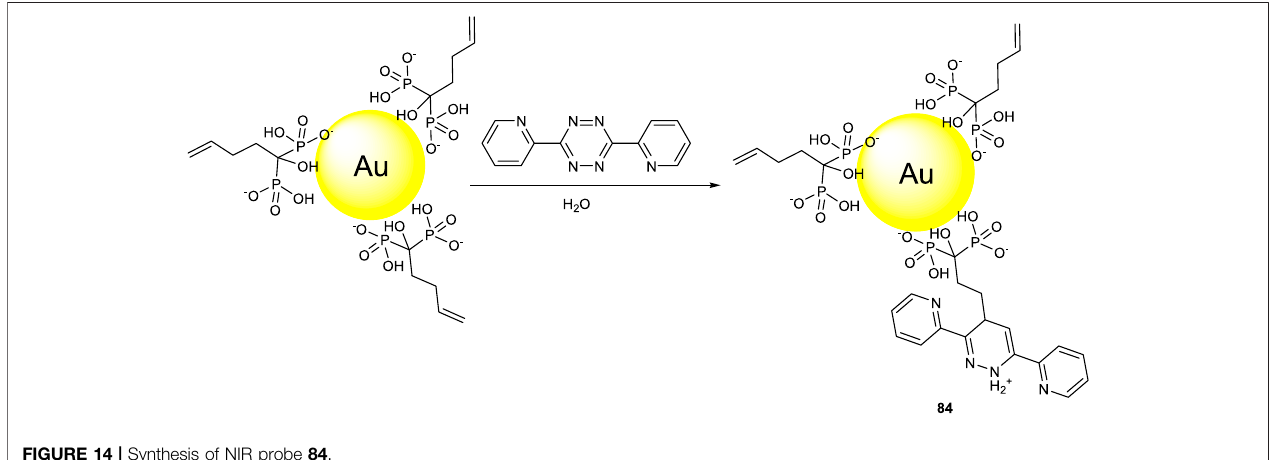
FIGURE 14 | Synthesis of NIR probe 84